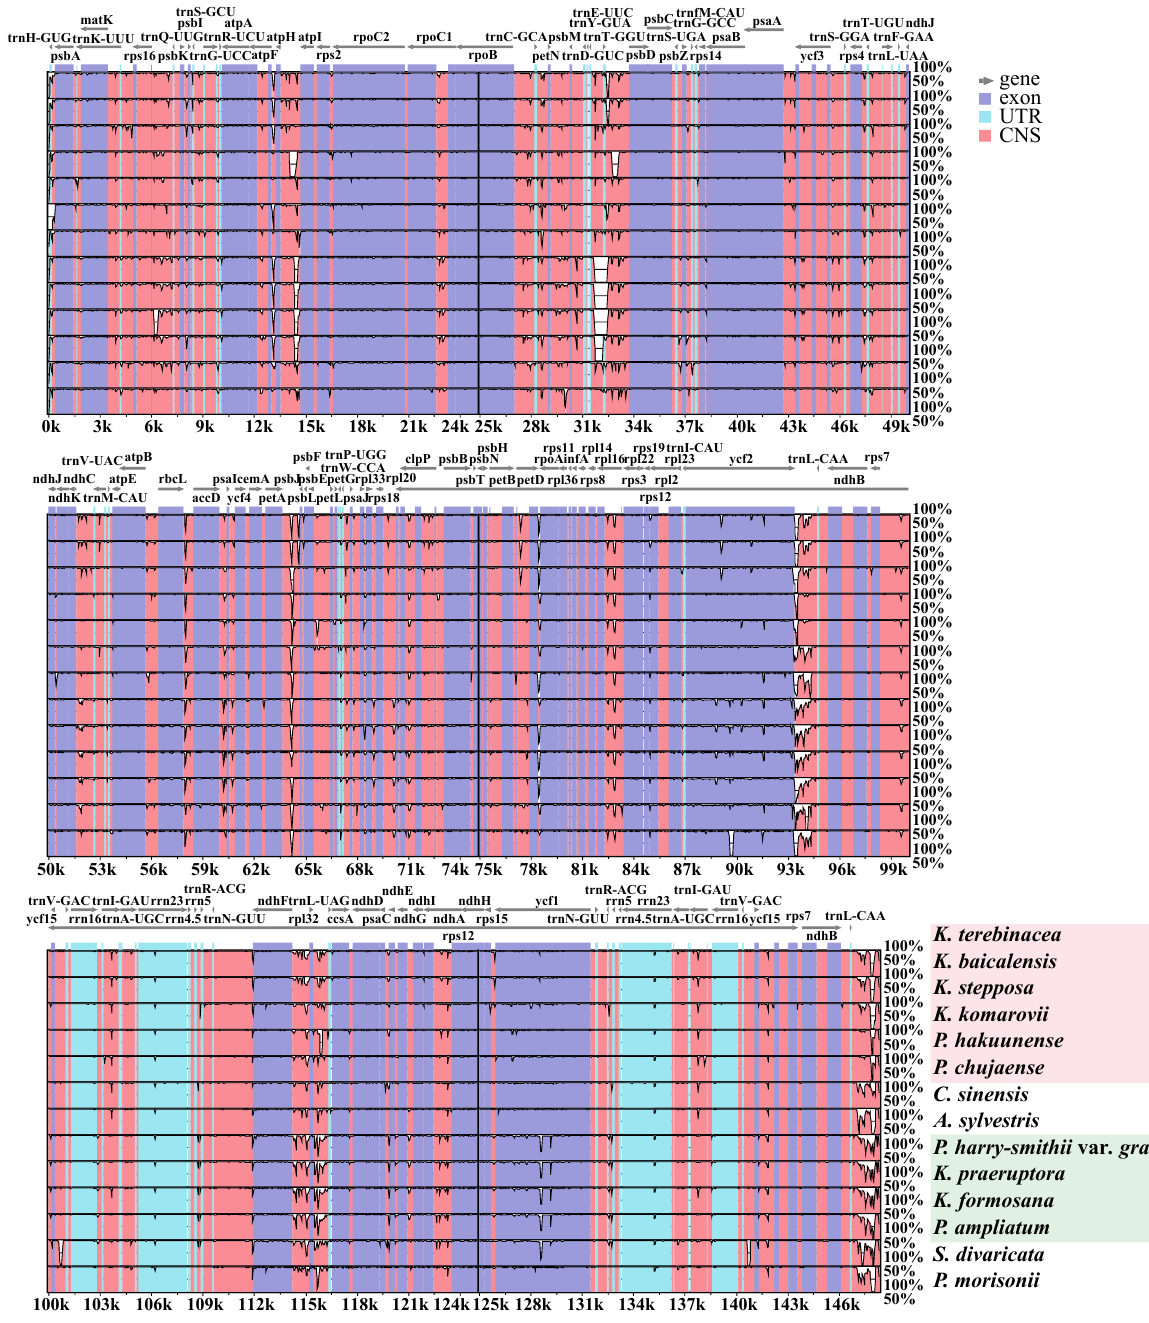
Figure 4. Sequence identity plot of the 14 plastomes with K. terebinthacea as the reference. The vertical scale represents the percentage of identity ranging from 50 to 100%. Coding and non-coding regions are marked in purple and pink,